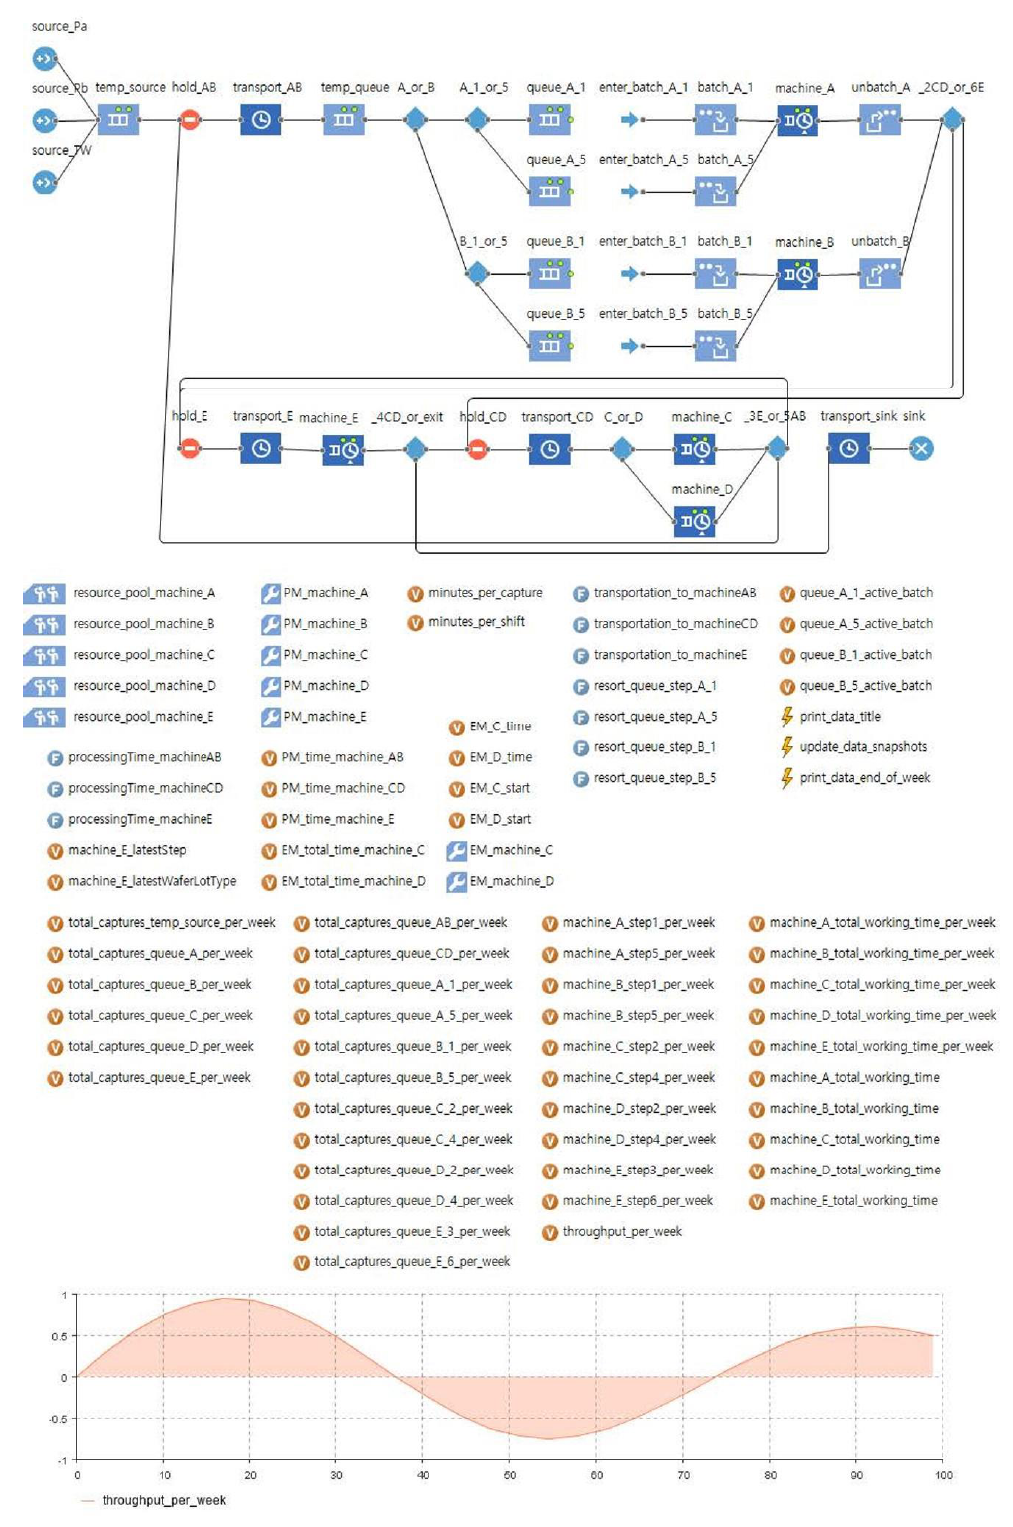
Figure 2. Intel minifab test bed in the Anylogic software.